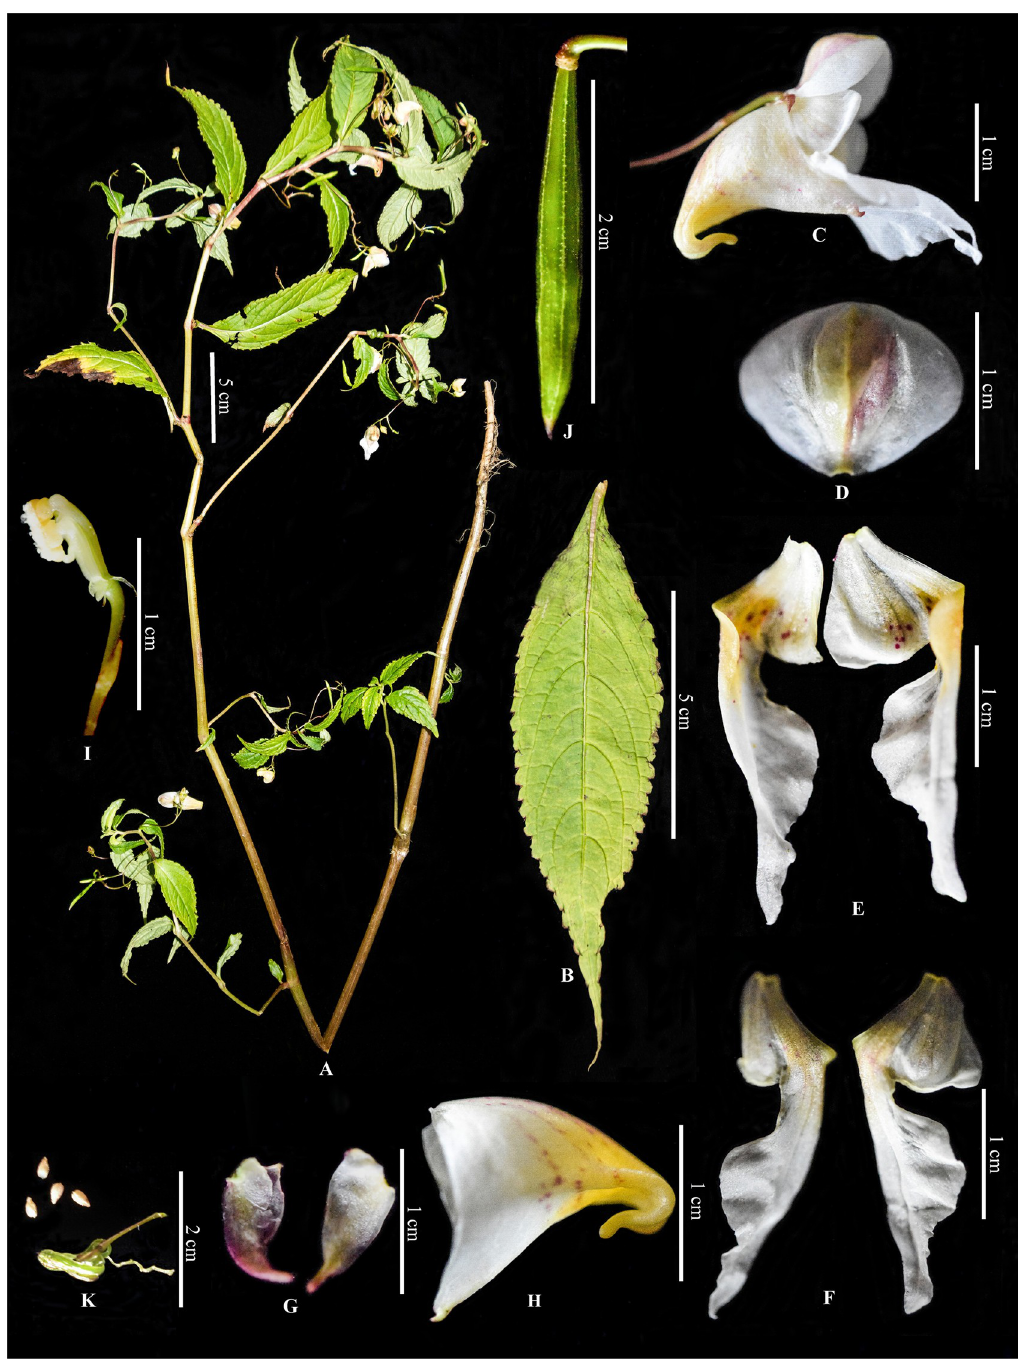
Fig 3. Impatiens nimspurjae : A. Flowering plant; B. Leaf; C. flower, side view; D. Dorsal petal (dorsal view); E. lateral united sepals (ventral view); F. lateral united sepals (dorsal view); G. Lateral sepal; H. Lower sepal; I. Ovary, pistil, pedicel and bract; J. Capsule; K. seeds. Photographs by Bhakta Bahadur